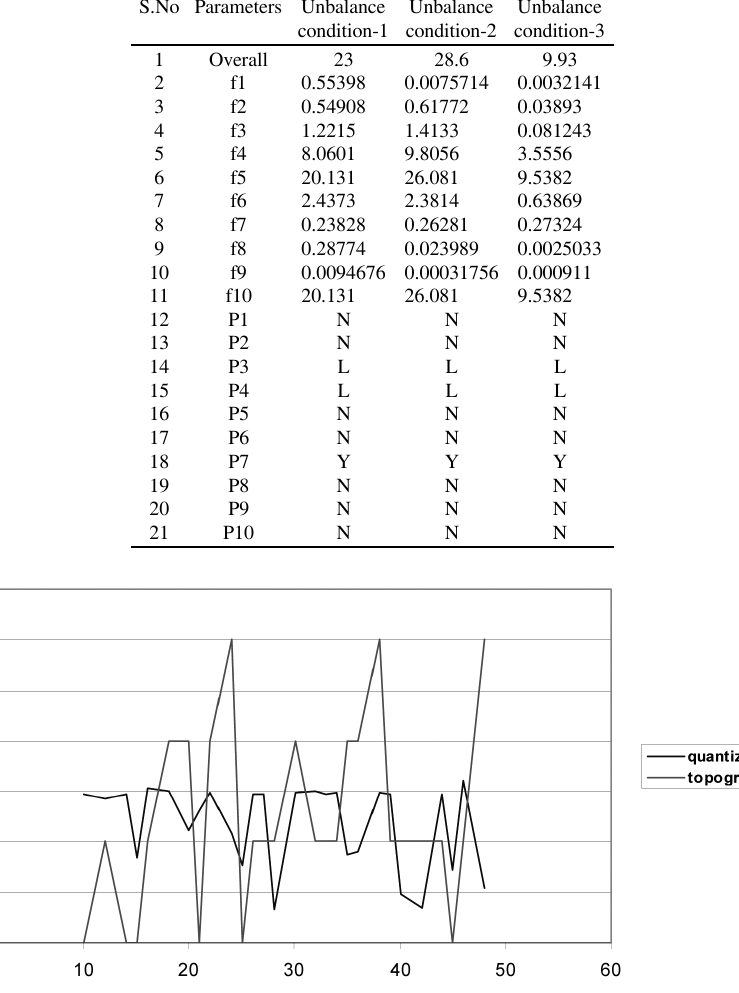
Table 3 Test data set for proposed SOFM network